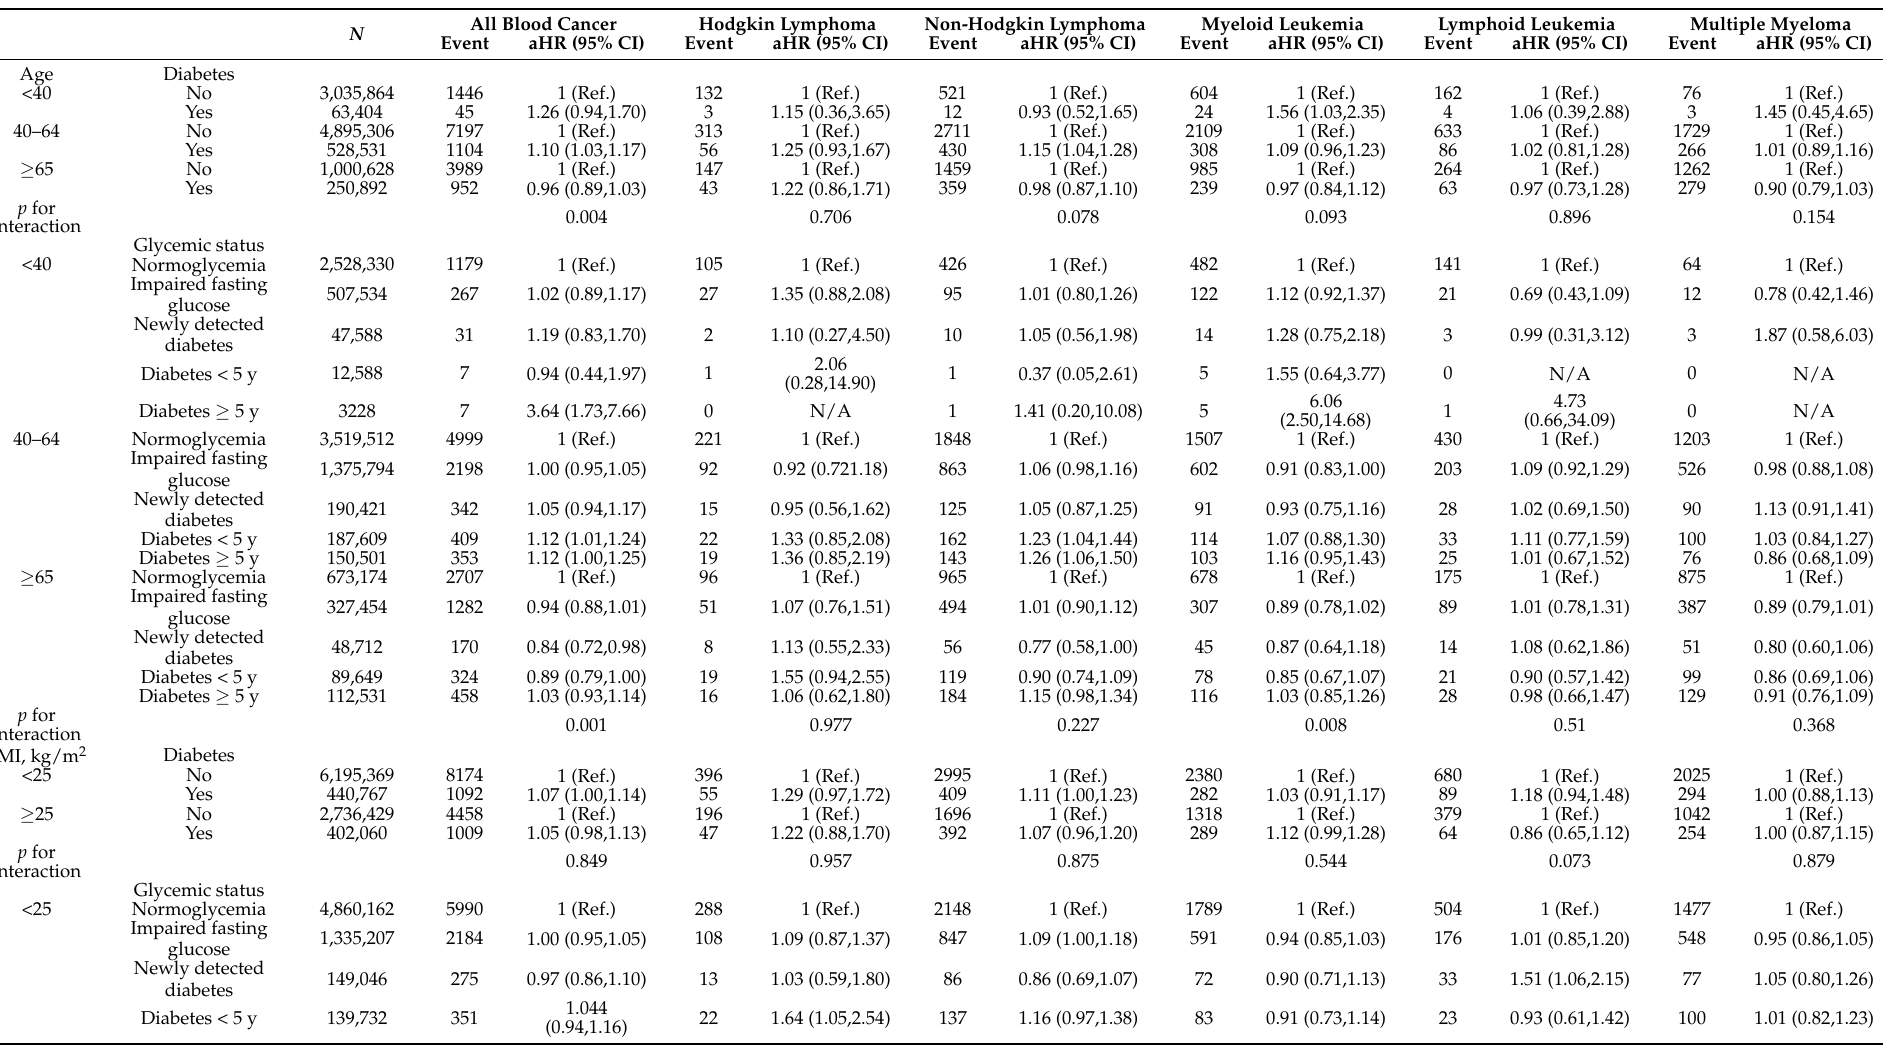
Table 4. Diabetes and glycemic status and risk of hematologic malignancies stratified by age and the body mass index